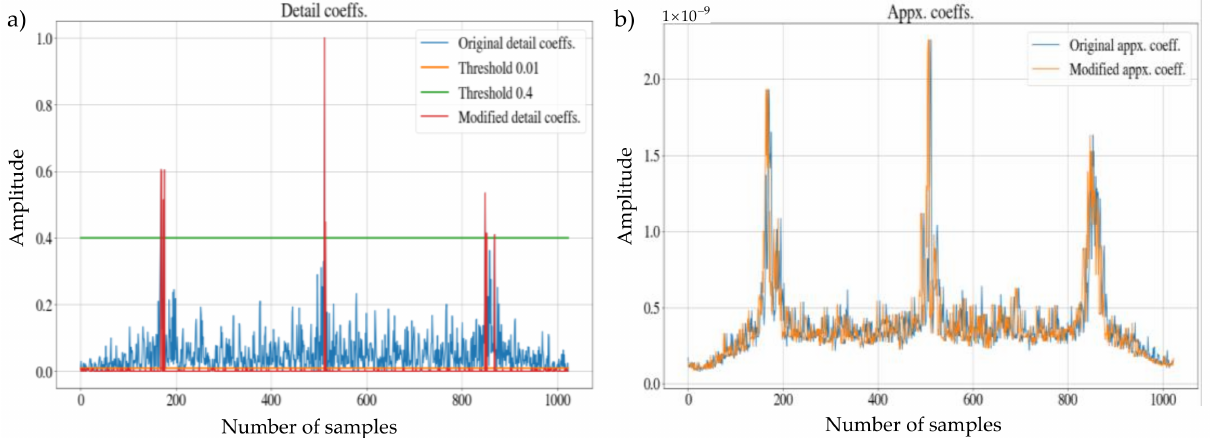
Figure 9. Original and modified coefficients: ( a ) approximation; ( b ) detailed view.